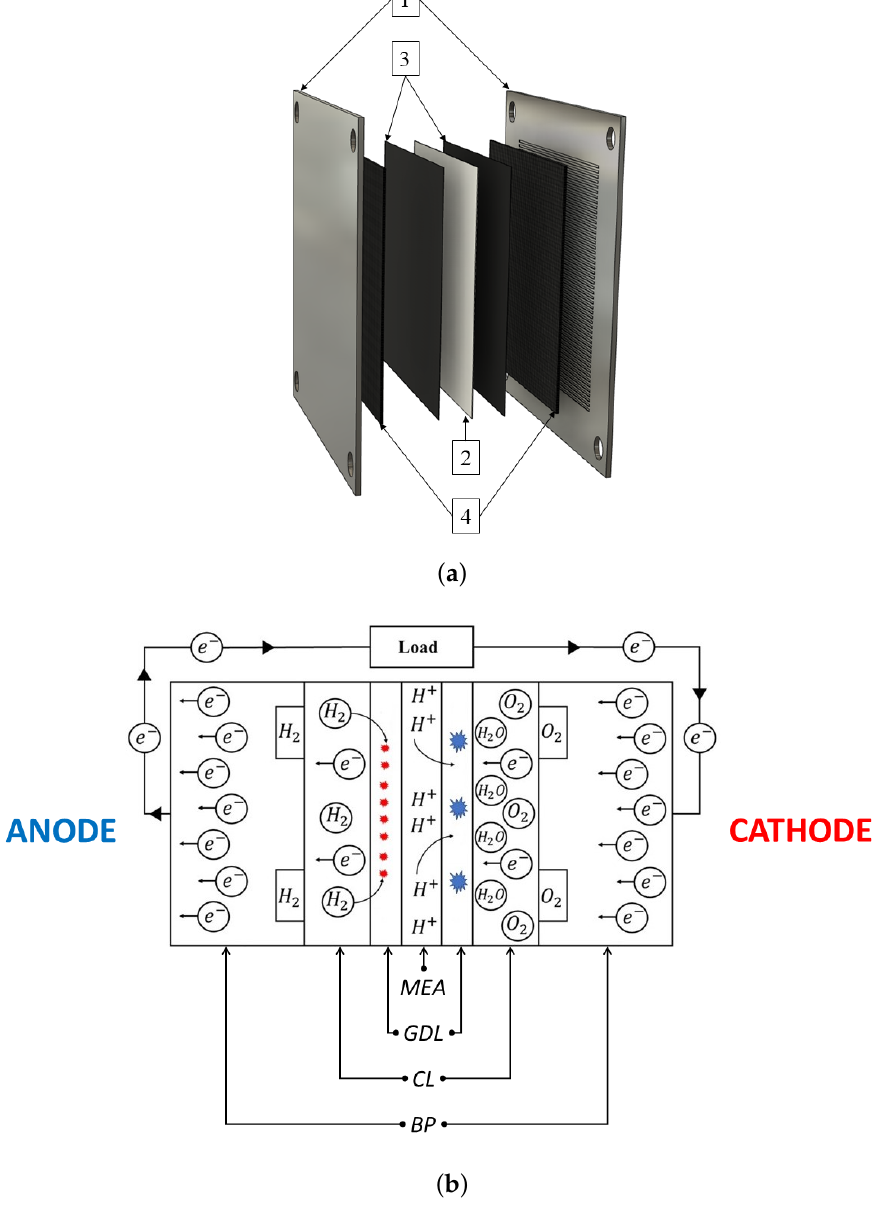
Figure 1. ( a ) FC structure (1) Bipolar Plates (BP), (2) Polymer Electrolyte Membrane (PEM), (3) Thin conductive catalyst, (4) Gas Diffusion Layer (GDL) with ( b ) the electro-chemical representation. v ohmic , the ohmic voltage drop can be expressed in Equation (3) where ρ m is the specific ionic resistivity of the membrane, ρ GDL the GDL resistivity, t m and t GDL represent the membrane and the GDL